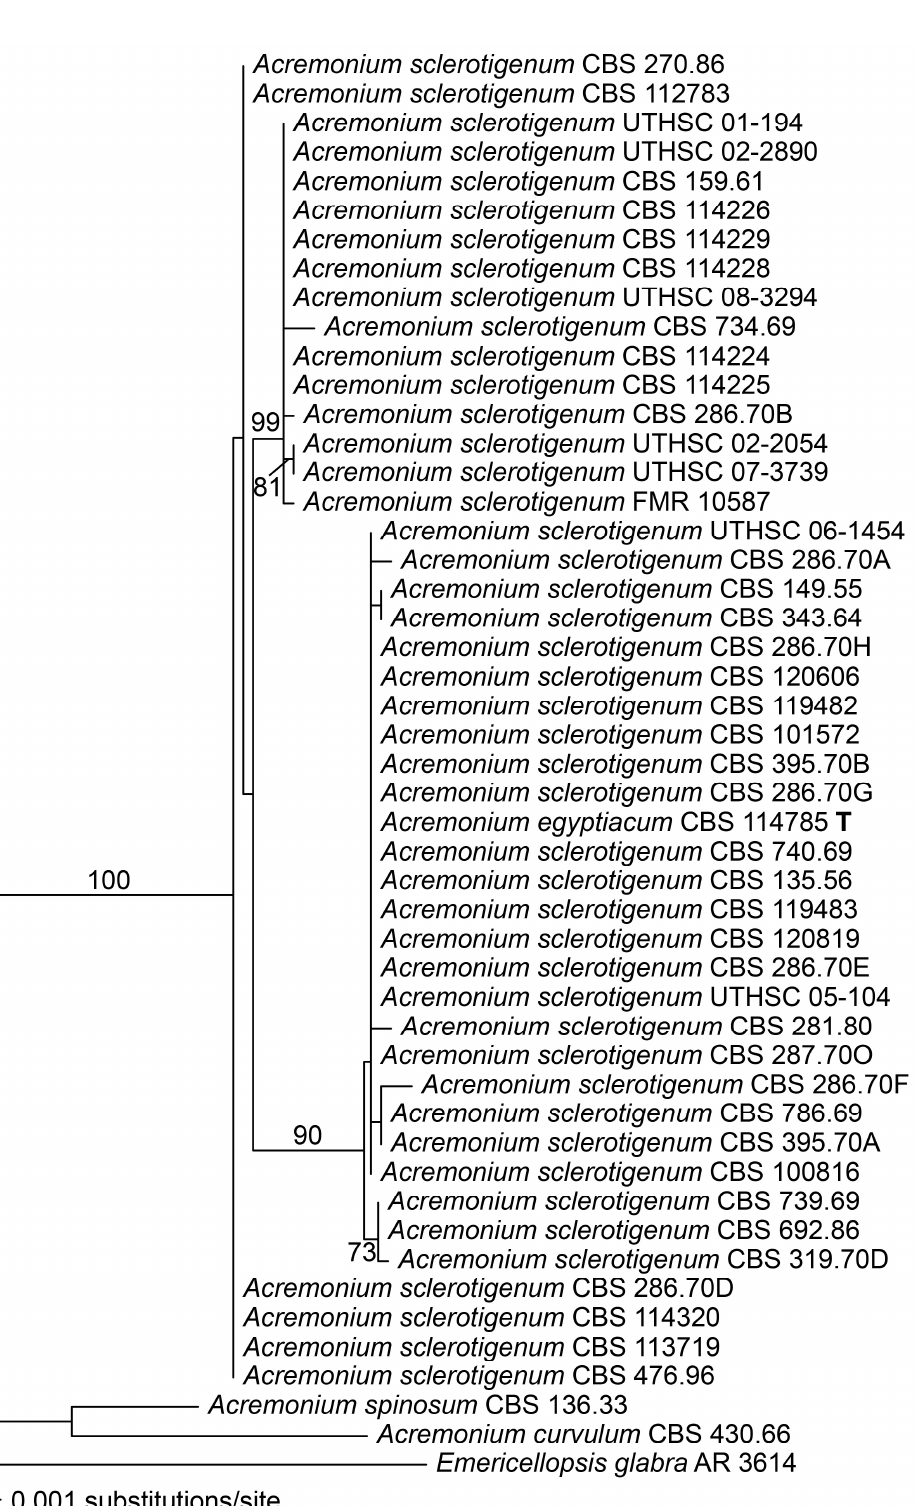
Figure 3. Phylogenetic disposition of the Acremonium sclerotigenum/egyptiacum complex as shown by a fragment of the actin gene amplified using the primers ACT1 and ACT4R, and analysed using maximum likelihood (ML) with RAxML VI-HPC. Support values were obtained using a fast bootstrap analysis of 1000 pseudoreplicates. Acremonium spinosum , A. curvulum , and Emericellopsis glabra appear as outgroups.